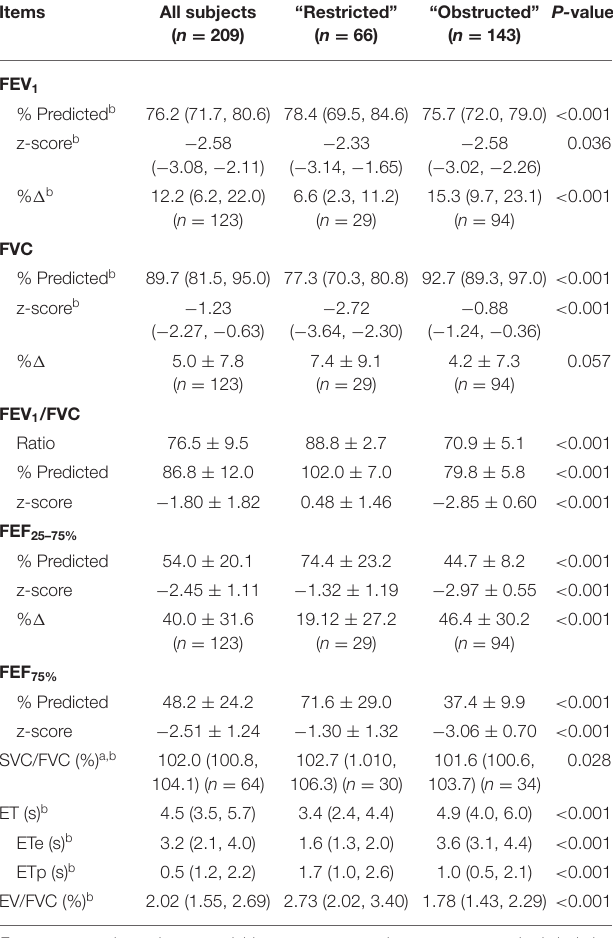
TABLE 2 | Spirometry of the study